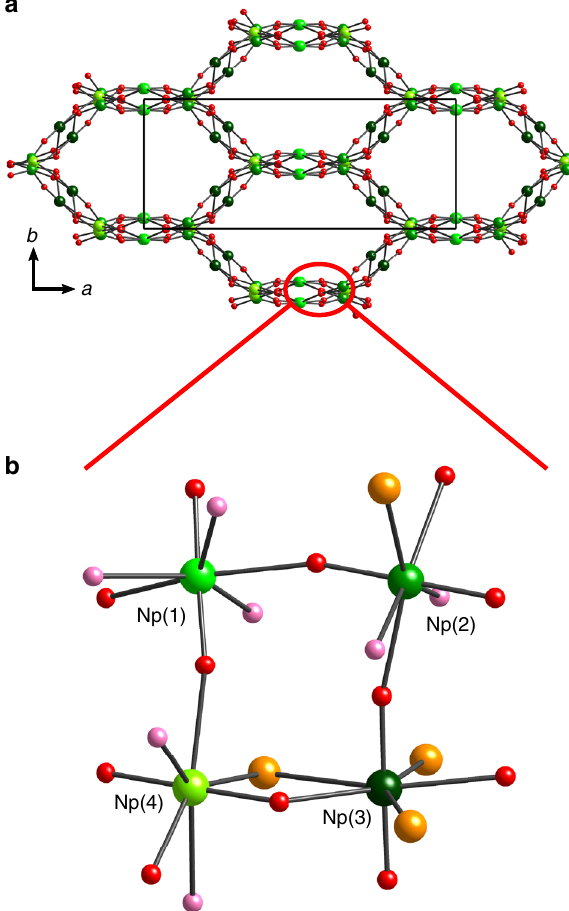
Fig. 3 Structure of (NpO 2 ) 4 Cl 4 (H 2 O) 7 ( 1 ). a Projection of the three- dimensional network of cation − cation-bonded Np V O 2 + square nets, with open channels along the [0 0 1] direction. Chloride anions and water molecules that reside inside the channels are omitted for clarity. b Local coordination environments and connectivities of four crystallographically unique Np V O 2 + cations in the structure of 1 . Half of the disordered Cl and O w positions are omitted for clarity. Green, red, pink, and orange spheres represent Np, O yl (yl = actinyl), O w (w = water), and Cl atoms, respectively